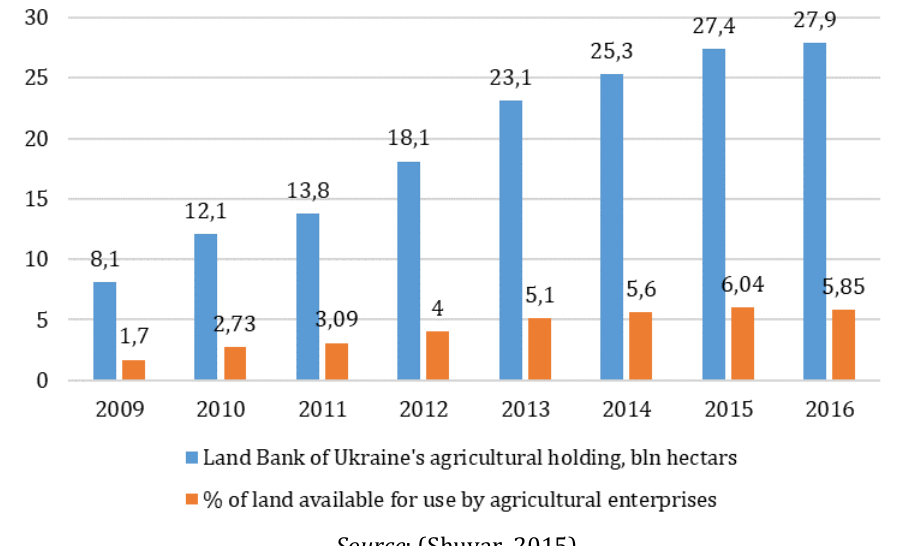
Source : (Shuvar, 2015)